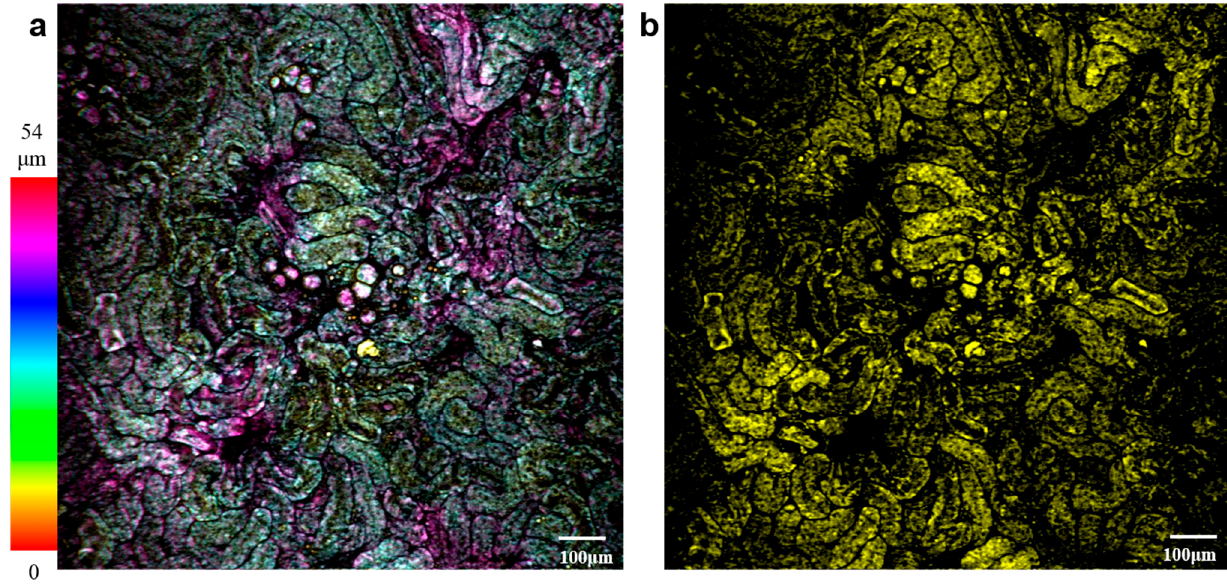
Figure 6. Two-photon volumetric imaging of mouse kidney tissue. ( a ) Projection of the Gaussian image stack of mouse kidney tissue color-coded by depth. ( b ) A single frame of the mouse kidney in the Airy mode.